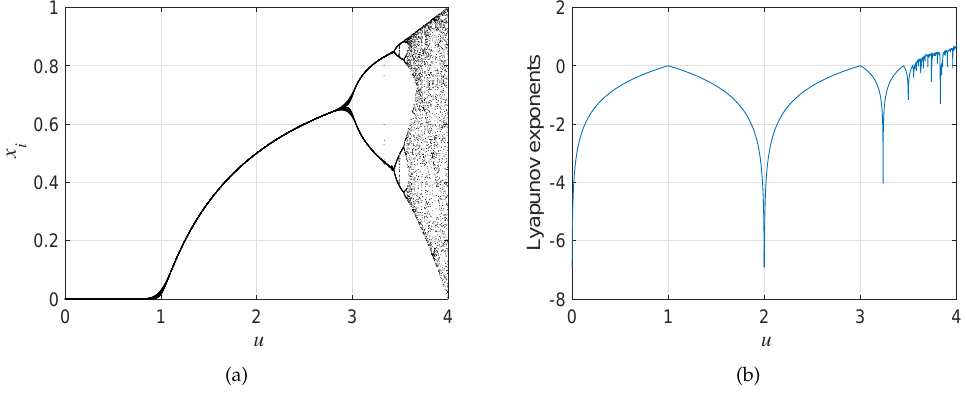
Figure 1. The ( a ) bifurcation diagram and ( b ) Lyapunov exponents of LM.